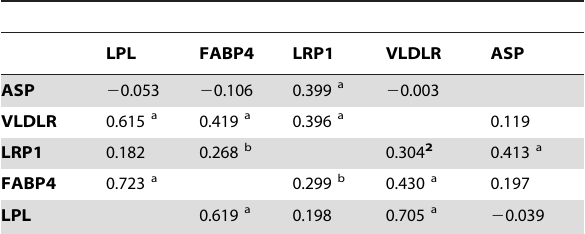
Table 7. Correlations between mRNA levels of the studied genes in both visceral and subcutaneous adipose tissue.